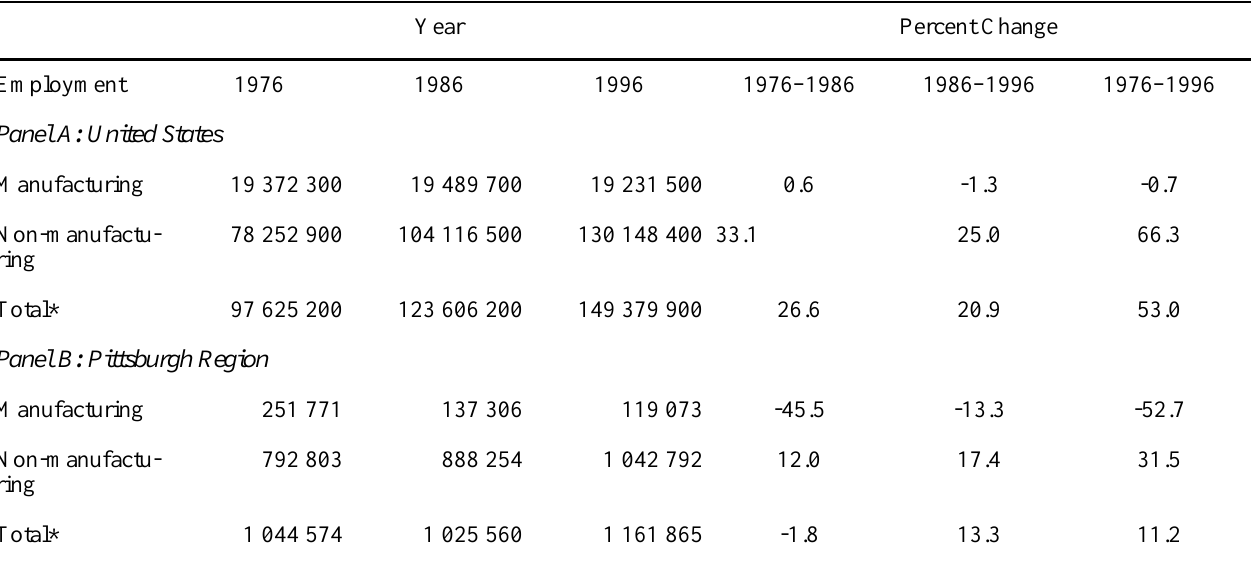
Table 1. Manufacturing and non-manufacturing employment in the U.S. and in the Pittsburgh Region,